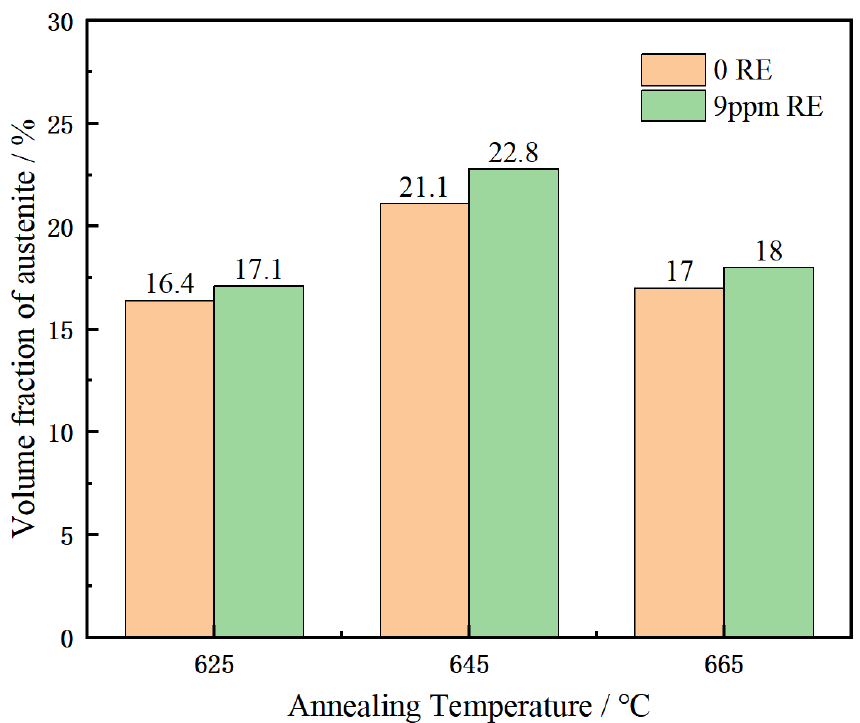
Figure 5. Residual austenite contents of the experimental steels at different annealing